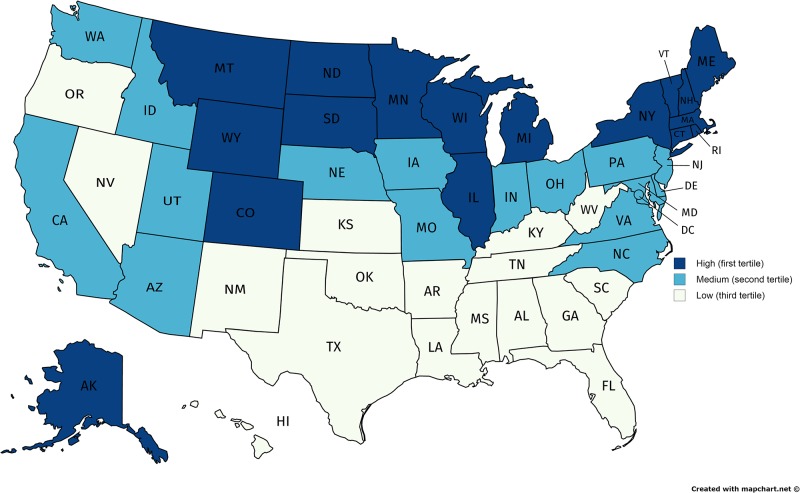
Descriptive statistics of USA hockey participation.States divided into low, medium and high participation levels in USA hockey.